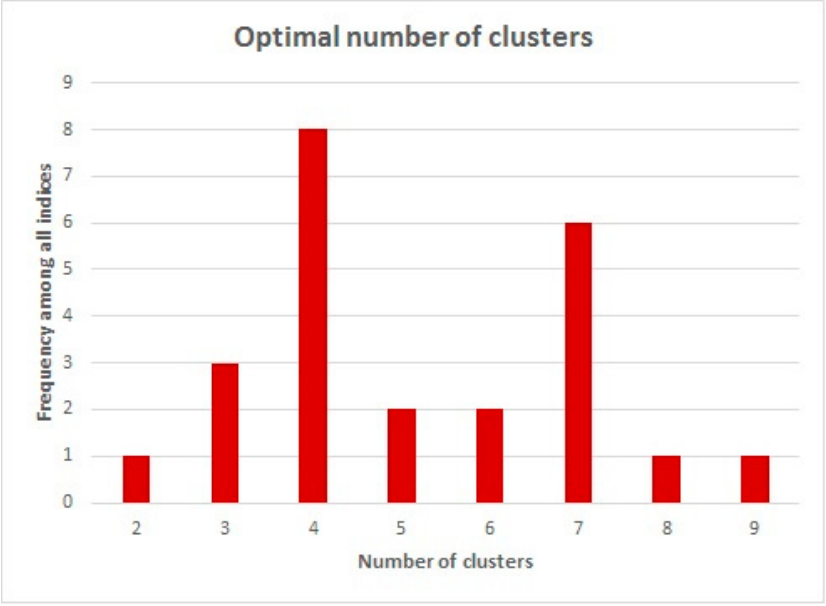
Figure 9. The frequency of the optimal number of clusters retrieved by 24 models.